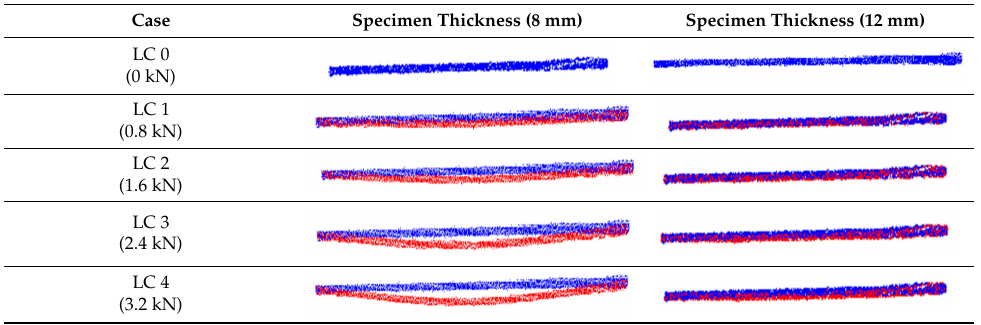
Table 8. Octree inner node visualization and node transformation area (8 and 12 mm specimens).